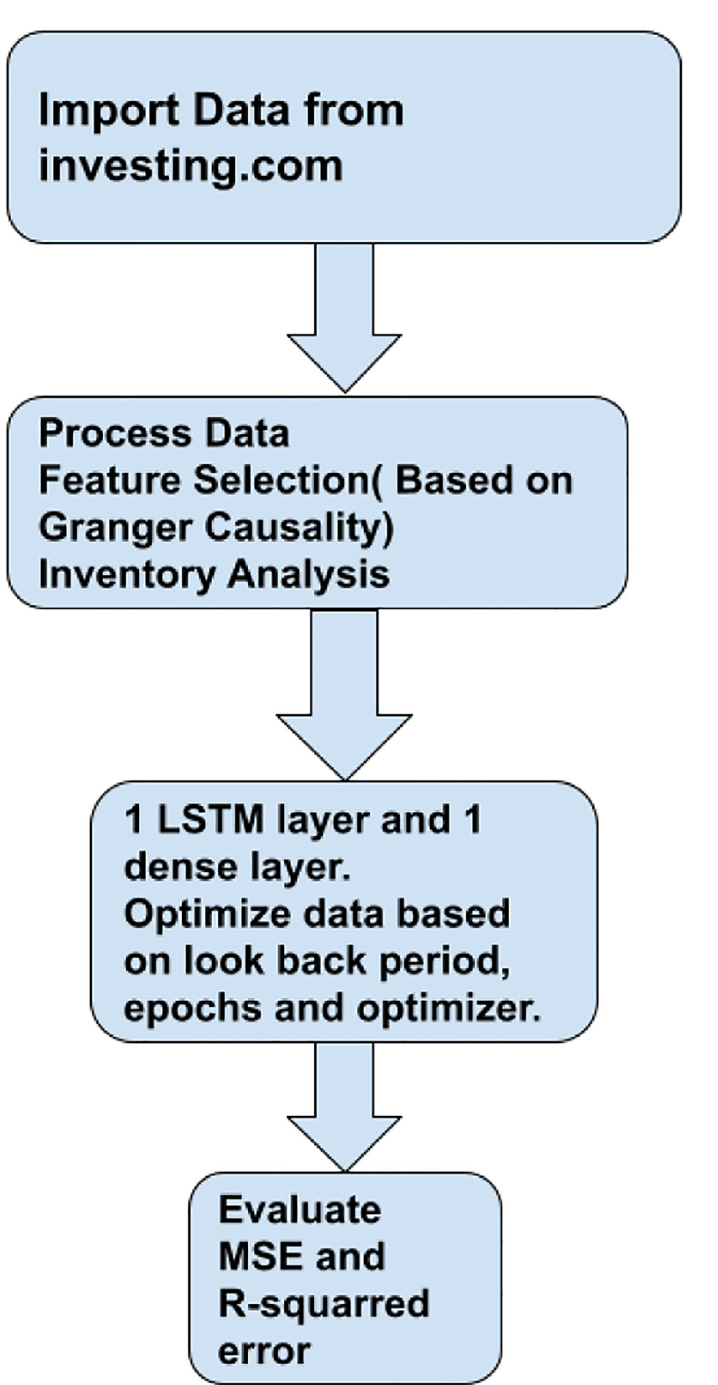
Fig 3. Flowchart of our